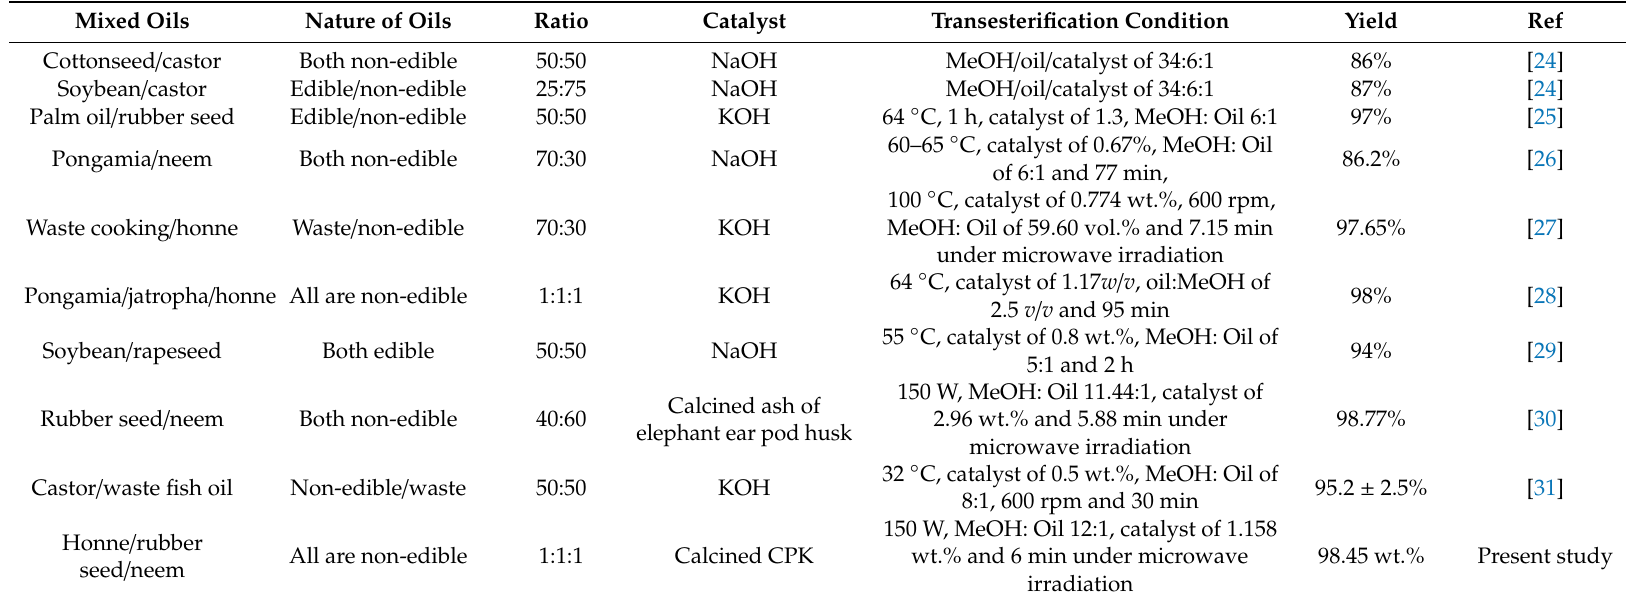
Table 5. Review of mixed oils transesterification reaction conditions and